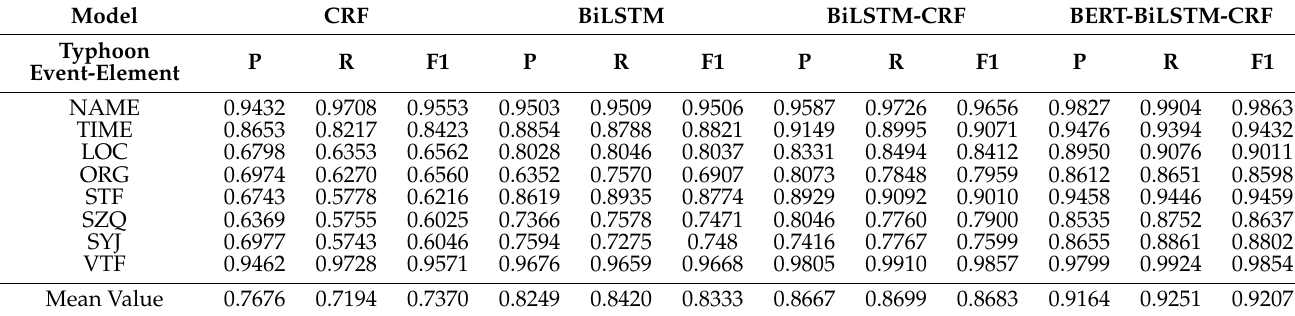
Table 7. Effect of typhoon event-elements extraction.